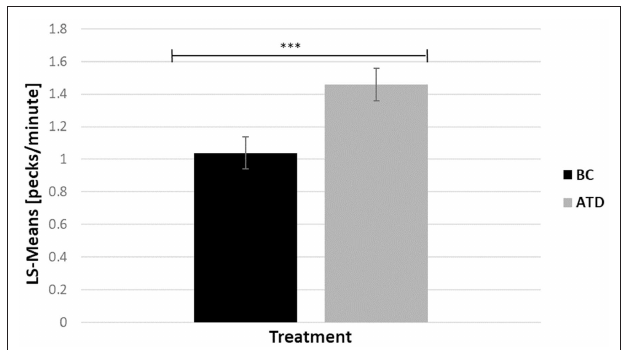
FIGURE 5 | Least square-means (pecks/minute) of key pecks during the 5-s delay before a food reward was released in acute tryptophan depletion (ATD)—treated birds and in balanced control (BC)—treated birds. Statistically significant results are indicated as *** P < 0.001.